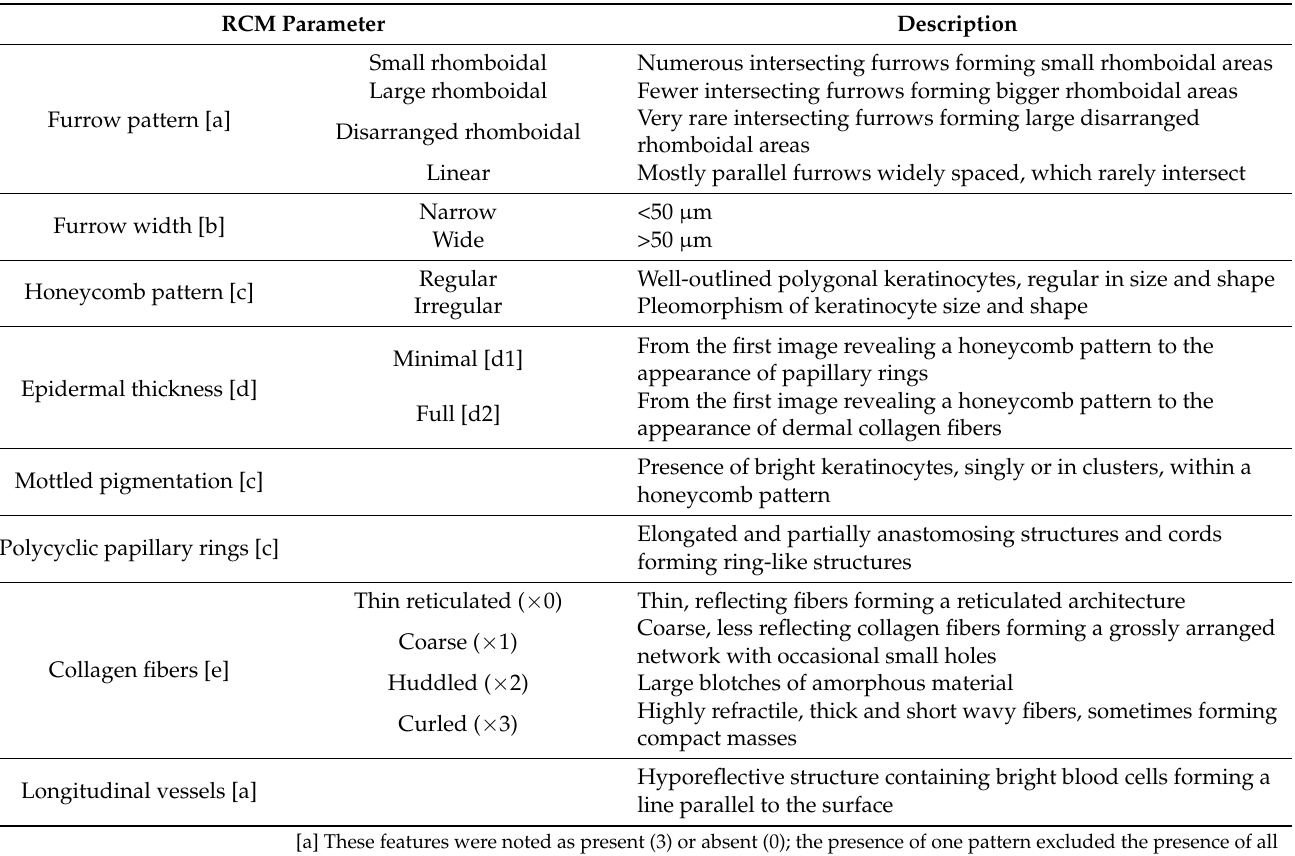
Table 1. Reflectance confocal microscopy (RCM) parameters related to skin aging